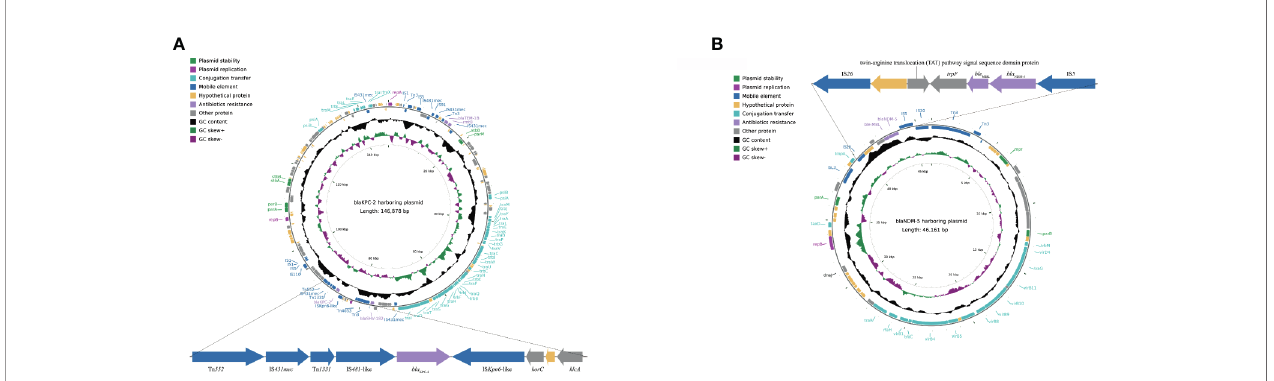
FIGURE 2 | Schematic maps of the bla KPC-2 -harboring plasmid (A) and the bla NDM-5 -harboring plasmid (B) . Genes are denoted by arrows and colored based on gene function classi fi cation. The innermost circle represents GC-Skew [G-C)/G+C]. The black circle represents GC content. The pKPC-CR-hvKP-C789 plasmid was used to reconstruct bla KPC-2 -harboring plasmid as reference plasmid (accession number: CP034417.1). The pCREC-591_4 plasmid was used to reconstruct